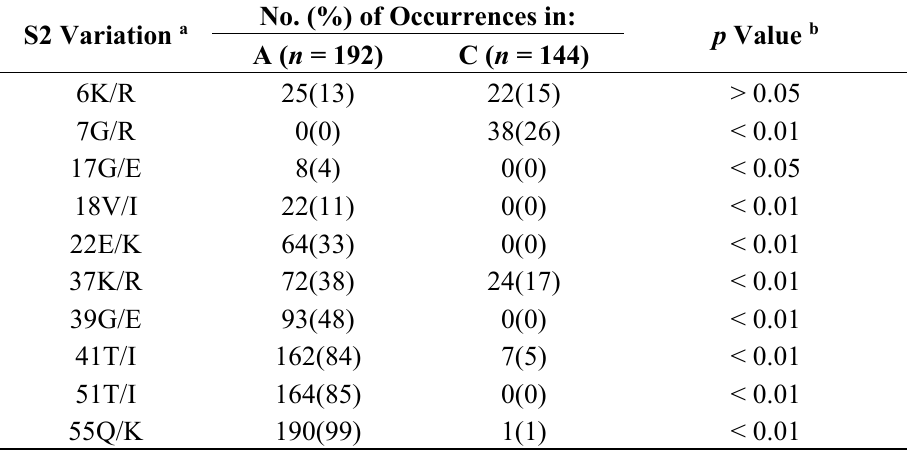
Table 3. Differences between S2 sequences derived from Branch A and Branch